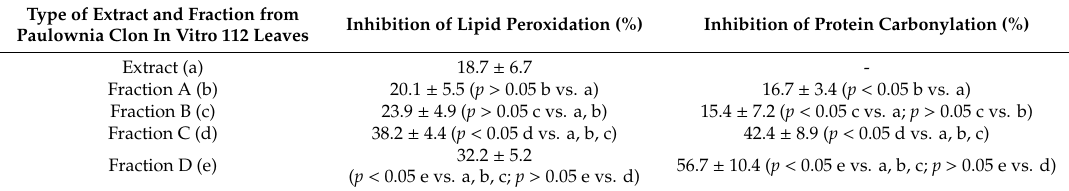
Table 4. Comparative effects of Paulownia Clone in Vitro 112 extract and the four fractions (A–D) at the tested dose (10 µg/mL) in selected biomarkers of oxidative stress in plasma treated with H 2 O 2 /Fe. Type of Extract and Fraction from Inhibition of Lipid Peroxidation Paulownia Clon In Vitro 112 Leaves